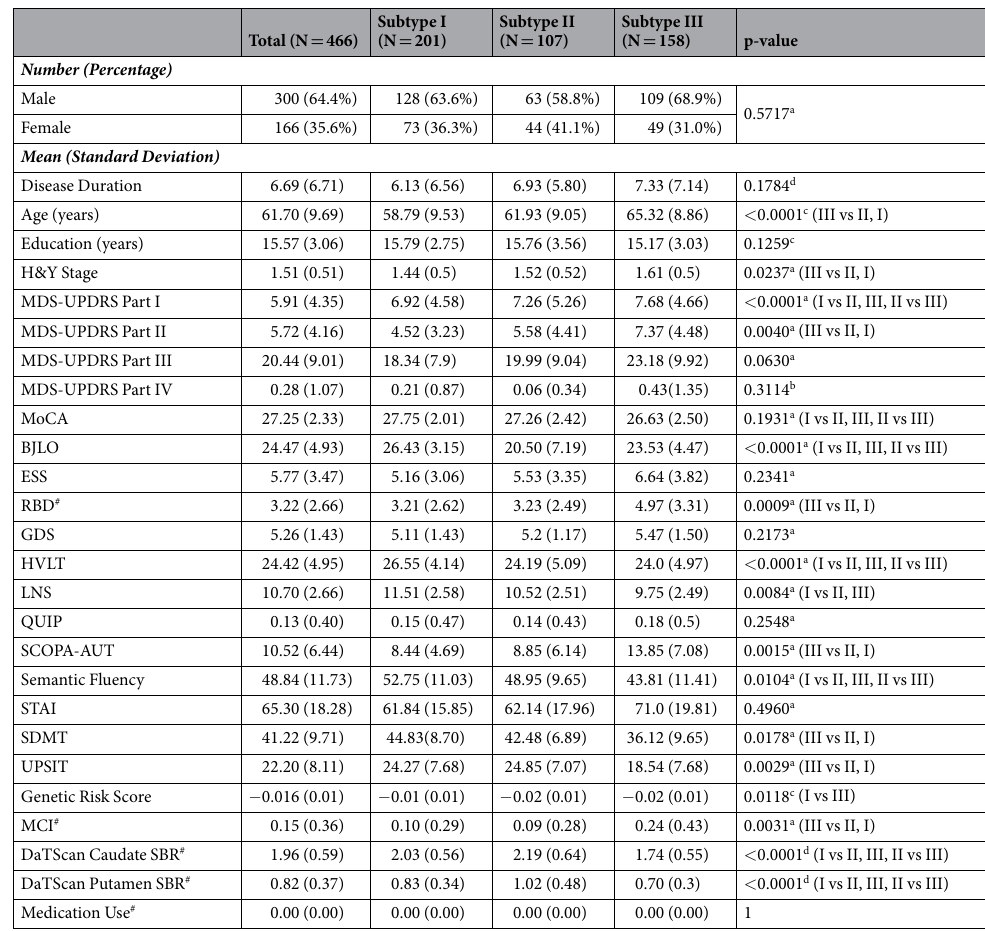
Table 1. Group characteristics of patients at the baseline in the three subtypes. a Chi-square test; b Fisher exact test; c One-way ANOVA test; d Kruskal-Wallis H-test. The specific different subtypes Determined by use of Tukey post hoc analysis. Abbreviations: H&Y: Hoehn and Yahr; MDS-UPDRS: Movement Disorders Society–revised Unified Parkinson’s Disease Rating Scale; MoCA: Montreal Cognitive Assessment; BJLO: Benton Judgment of Line Orientation; ESS: Epworth Sleepiness Scale; RBD: Rapid eye movement sleep Behavior Disorder; GDS: Geriatric Depression Scale; HVLT: Hopkin’s Verbal Learning Test; LNS: Letter Number Sequencing; QUIP: Questionnaire for Impulsive-Compulsive Disorders in Parkinson’s Disease; SCOPA-AUT: SCales for Outcomes in PArkinson’s disease-AUTomotic symptoms; STAI: State Trait Anxiety Inventory; SDMT: Symbol